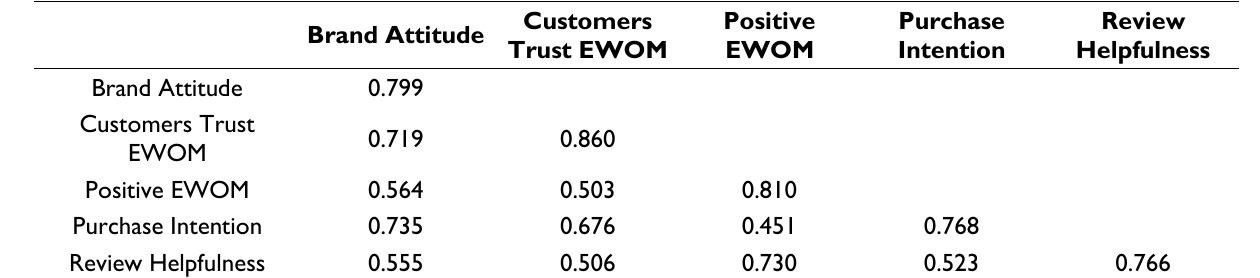
Table 4. Discriminant Validity Testing Result Brand